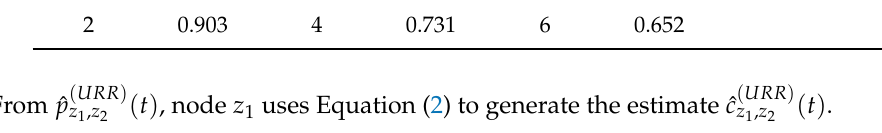
( LS ) ( t ) received from node z z 1 , z 2 ( LS ) ( t ) z 1 , z 2